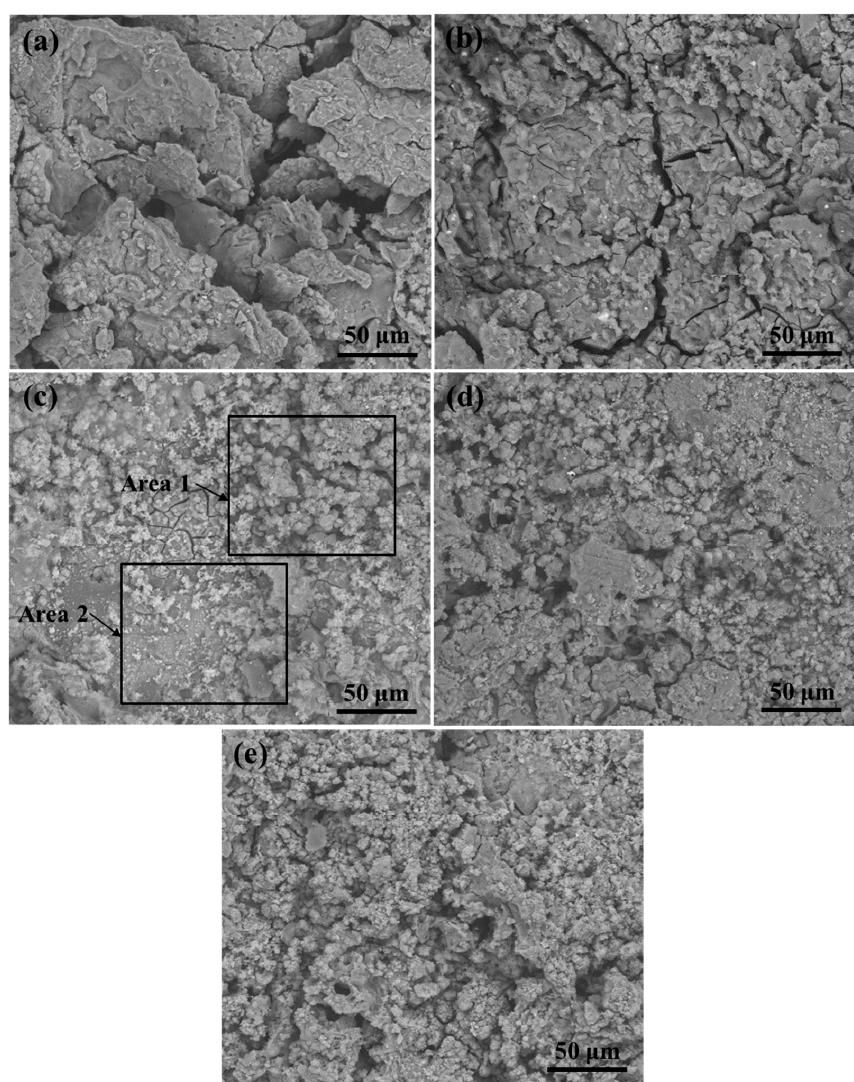
Figure 4. The surface morphology of the Mg-3Zn/ x HA composites after immersion in the simulated body fluid (SBF) solution for 48 h: ( a ) Mg-3Zn alloy; ( b ) Mg-3Zn/2.5HA; ( c ) Mg-3Zn/5HA; ( d ) Mg-3Zn/7.5HA and ( e ) Mg-3Zn/10HA composite.